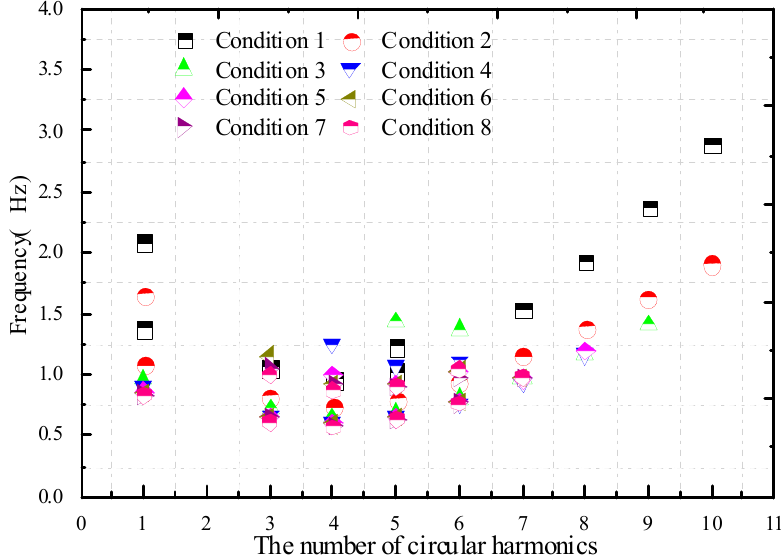
Figure 8. Changes of frequencies with the number of circumferential harmonics under each working condition.